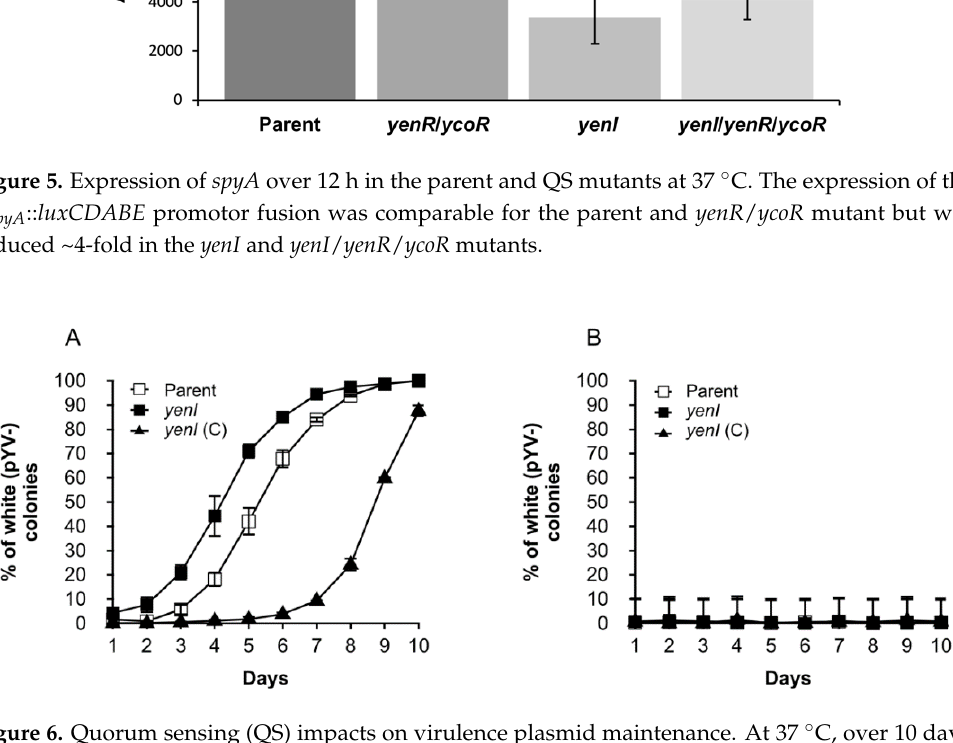
Figure 6. Quorum sensing (QS) impacts on virulence plasmid maintenance. At 37 °C, over 10 days, the number of white, pYVe virulence, plasmid-negative colonies was greater in the yenI mutant compared to the parent, and complementation ( yenI (C)) over-compensated and reduced the rate of plasmid loss to levels well below that of the parent ( A ). At 22 °C, the number of white colonies remained low and stable over ten days with no differences between the parent and QS mutant ( B ).